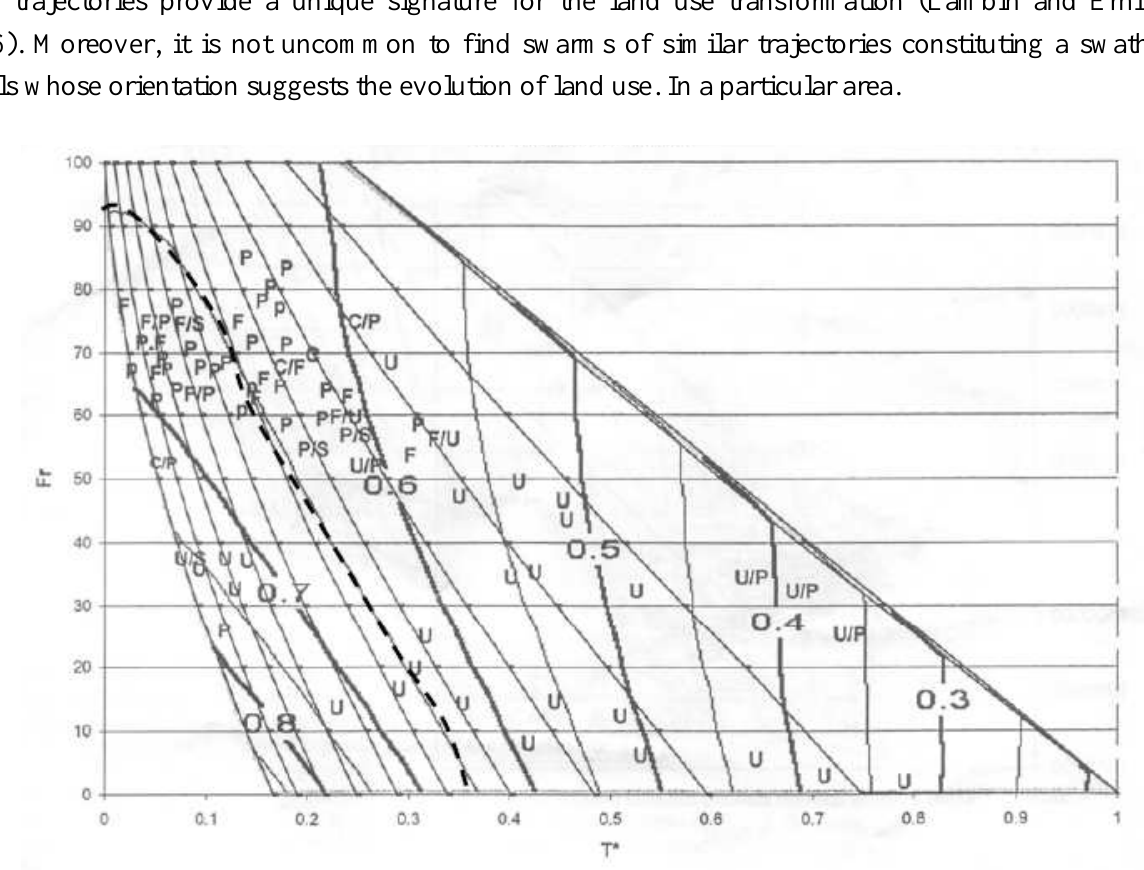
Figure 5. Scatterplot of selected pixels within the triangle, whose axes are labeled as Fr and T*, for an AVHRR image over a region around San Jose’, Costa Rica, on 24 December, 1990. Pixels are labeled as either forest (F), pasture (P), urban (U) or cropland (S). The nearly straight lines slanting upward toward the left are isopleths of Mo at intervals of 0.1 (ranging from zero along the warm edge to 1.0 at the cold side of the distribution). The curved lines labeled in fractions (all except for the dashed line representing the 0.55 value) are isopleths of